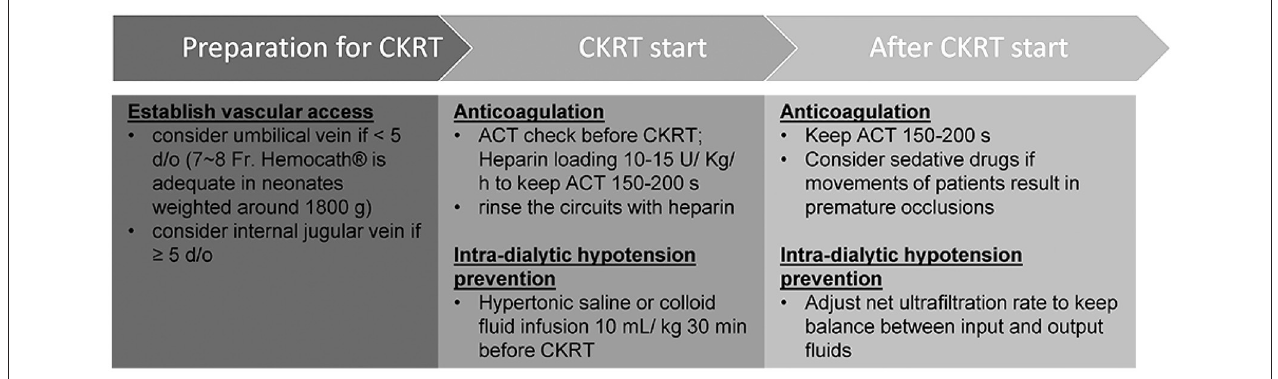
FIGURE 2 | Modified protocol of continuous kidney replacement therapy for neonates with low body